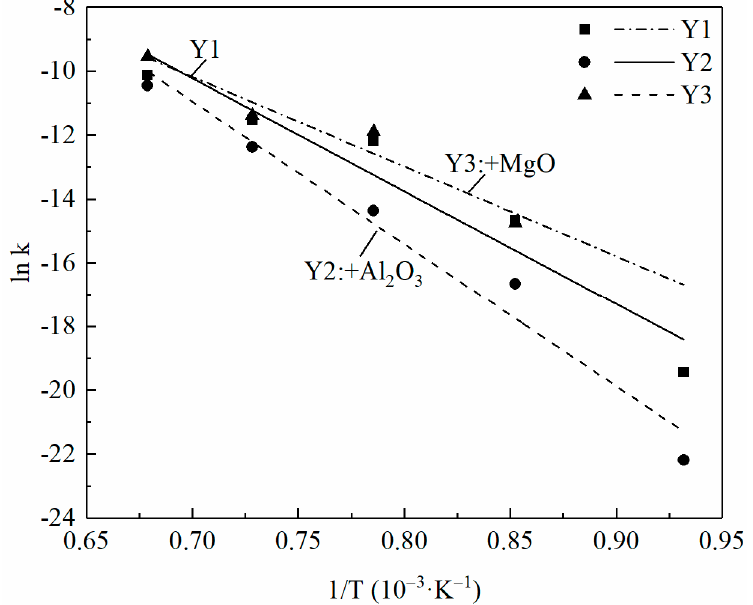
Figure 10. The relationship between ln(k) and 1/T for the reduction reaction in the diffusion-controlled stage; the symbols are experimental results and the lines are data fitting.